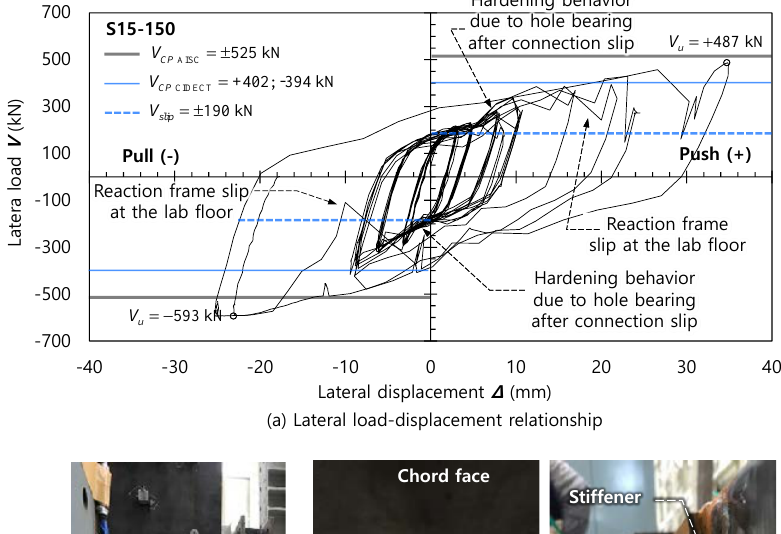
p = 15 mm) were significantly reduced at the stiffened K-connection of S15–150